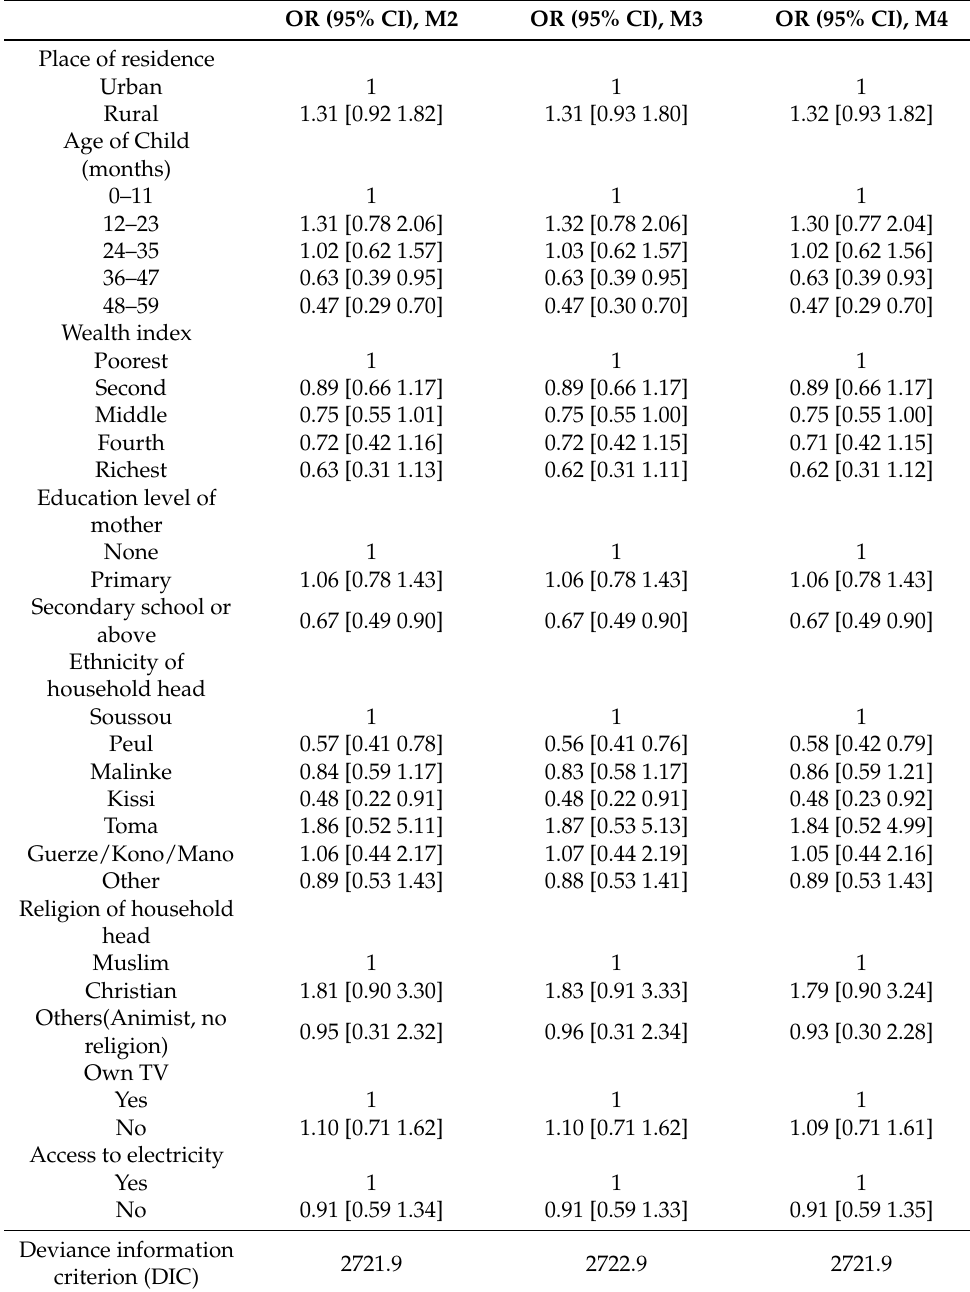
Table 4. Factors associated with anemia from the models after adjusting the non-spatial, spatial random effects and convolution